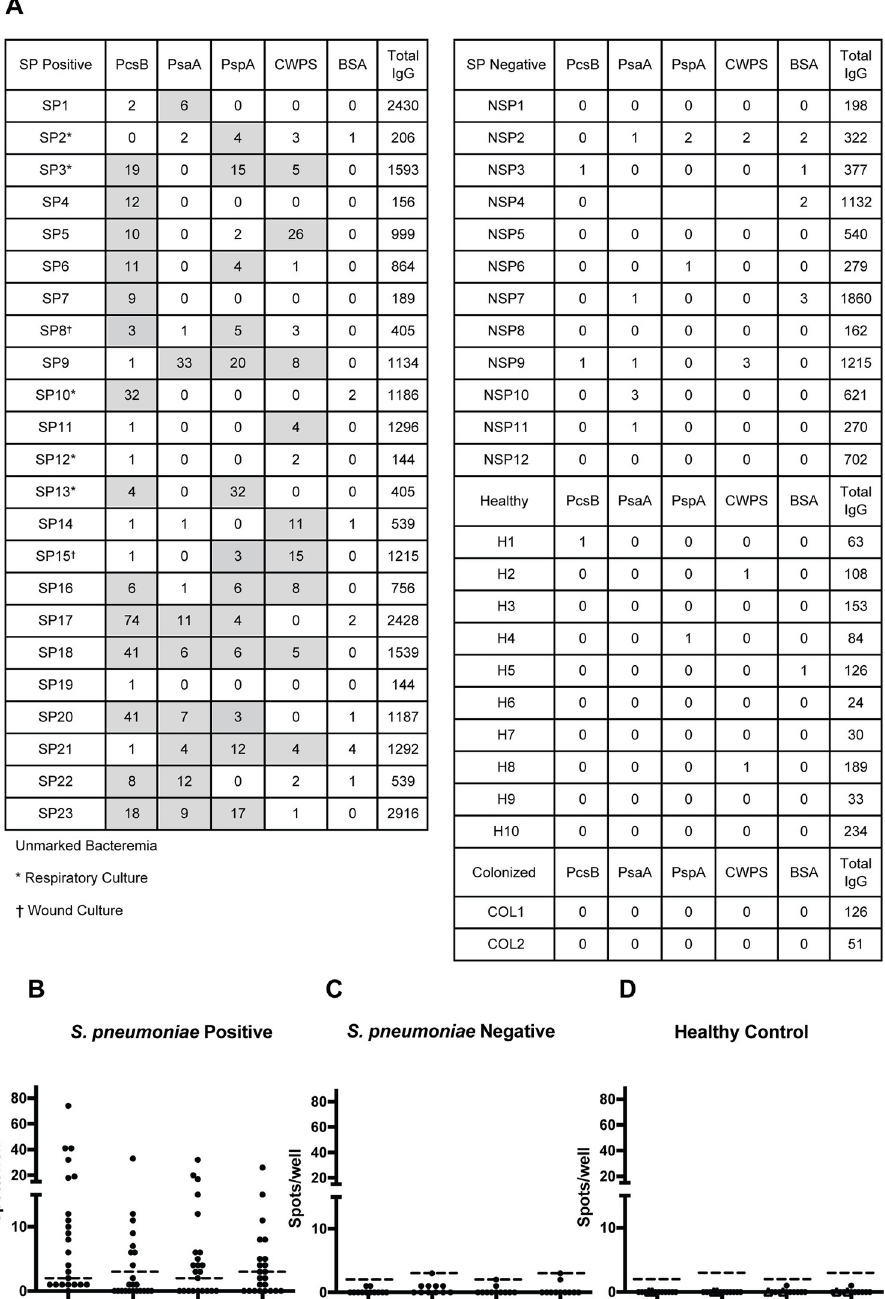
Fig 2. Antibody secreting cells produce antibodies specific for the four S . pneumoniae antigens in blood of patients with S . pneumoniae infections. Numbers of IgG-secreting cells (per 500,000 cells) specific to antigens (PcsB, PsaA, PspA, CWPS) in blood samples of patients with S . pneumoniae -infection (SP1-23), patients with non- S . pneumoniae -infection (NSP1-12), healthy controls with lytA -negative nasal swabs (H1-10), and lytA -positive nasal swabs (COL1-2) as measured by ELISpot (A). Spot numbers greater than C 0 for each antigen are highlighted in gray. Summary of the number of spots in ELISpot immunoassays positive for each of four antigens in patients with S . pneumoniae infection (B; n = 23), patients with non- S . pneumoniae infection (C; n = 12) and healthy controls (D; n = 12). Healthy controls include subjects colonized (open triangles; n = 2) and not colonized (closed circles; n = 10) as determined by lytA PCR. Each data point represents one patient’s response specific for the indicated antigen in the number of spots/well minus background. The dashed horizontal lines indicate the diagnostic value, C 0 , the cut-off